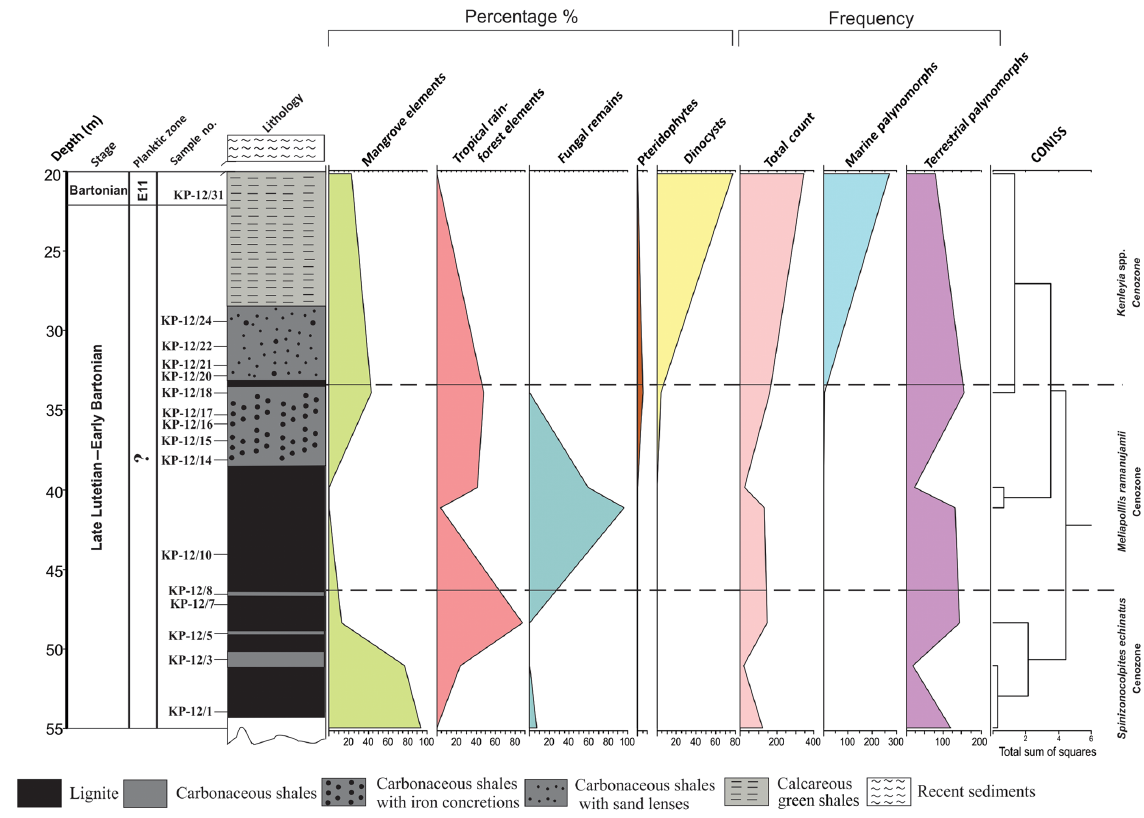
Figure 10. Distribution of a group of palynomorph taxa in the Panandhro lignite mine, Kutch